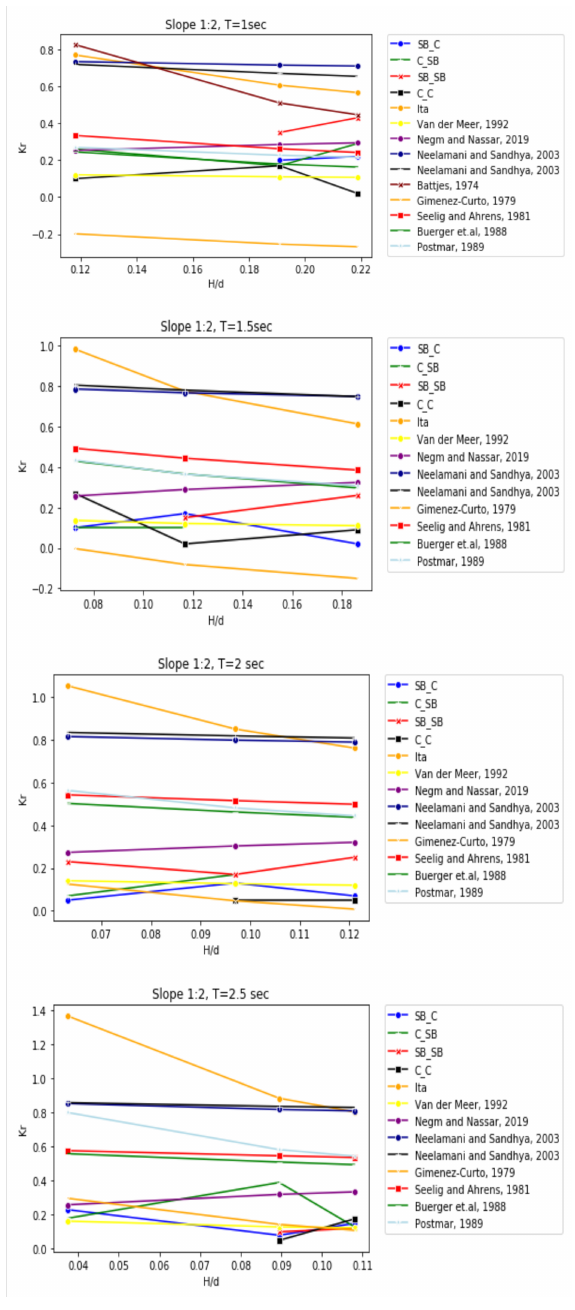
Figure 17. Kr for T in range 1 to 2.5 s. Source: